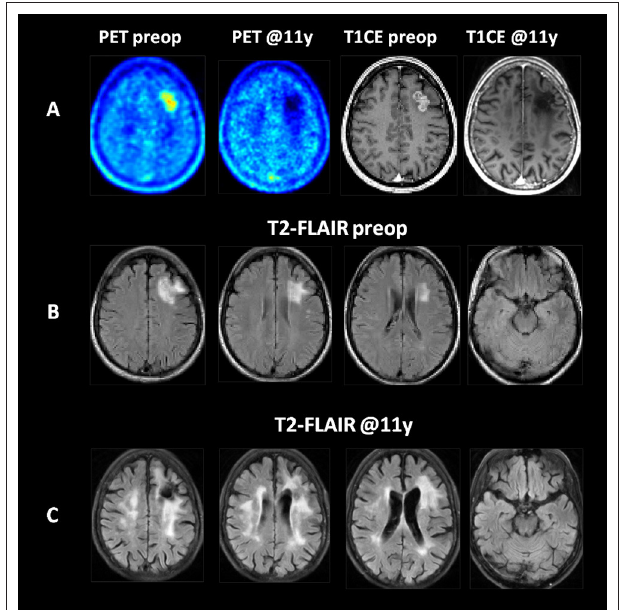
FIGURE 1 | Imaging findings at initial diagnosis and at 11 years of follow-up in a patient with a left frontal NSCLC (adenocarcinoma) brain metastasis treated by resection and whole brain radiotherapy. (A) The T1-weighted contrast enhanced MR (T1CE) and FET PET (PET) images revealed a contrast enhancing, PET-positive metastatic tumor with no evidence of recurrence in the brain or resection cavity during follow up. (B) The T2-FLAIR images at initial diagnosis. (C) At follow-up, extensive areas of T2-FLAIR hyperintensities developed in the white matter of the bilateral dorsal frontal and parietal lobes. All images are shown after elastic registration to the MNI-152 standard brain